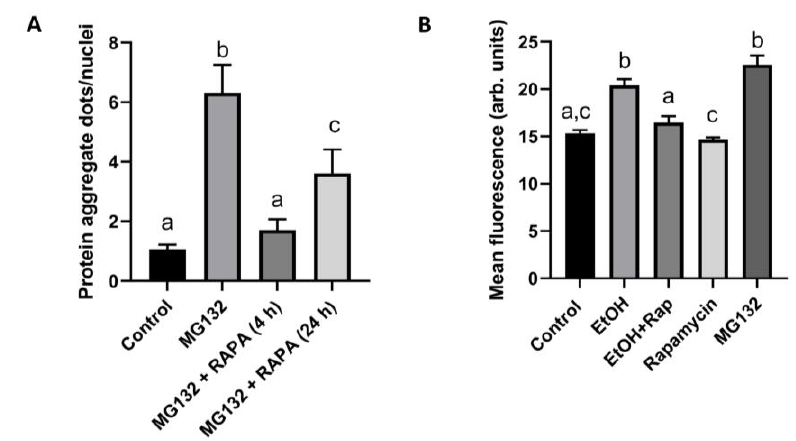
Figure 4. ( A ) Protein aggregates in VL-17A cells treated with MG132 for 16 h and then exposed to 100 nM rapamycin as indicated in the abscissa and ( B ) flow cytometric analysis of aggresome fluorescence in VL-17A cells treated with 25 mM EtOH for 48 h and then exposed to 100 nM rapamycin for 4 h. Some cells were treated with MG132 for 16 h. Letters have same meaning as in Figures 1 and 2.